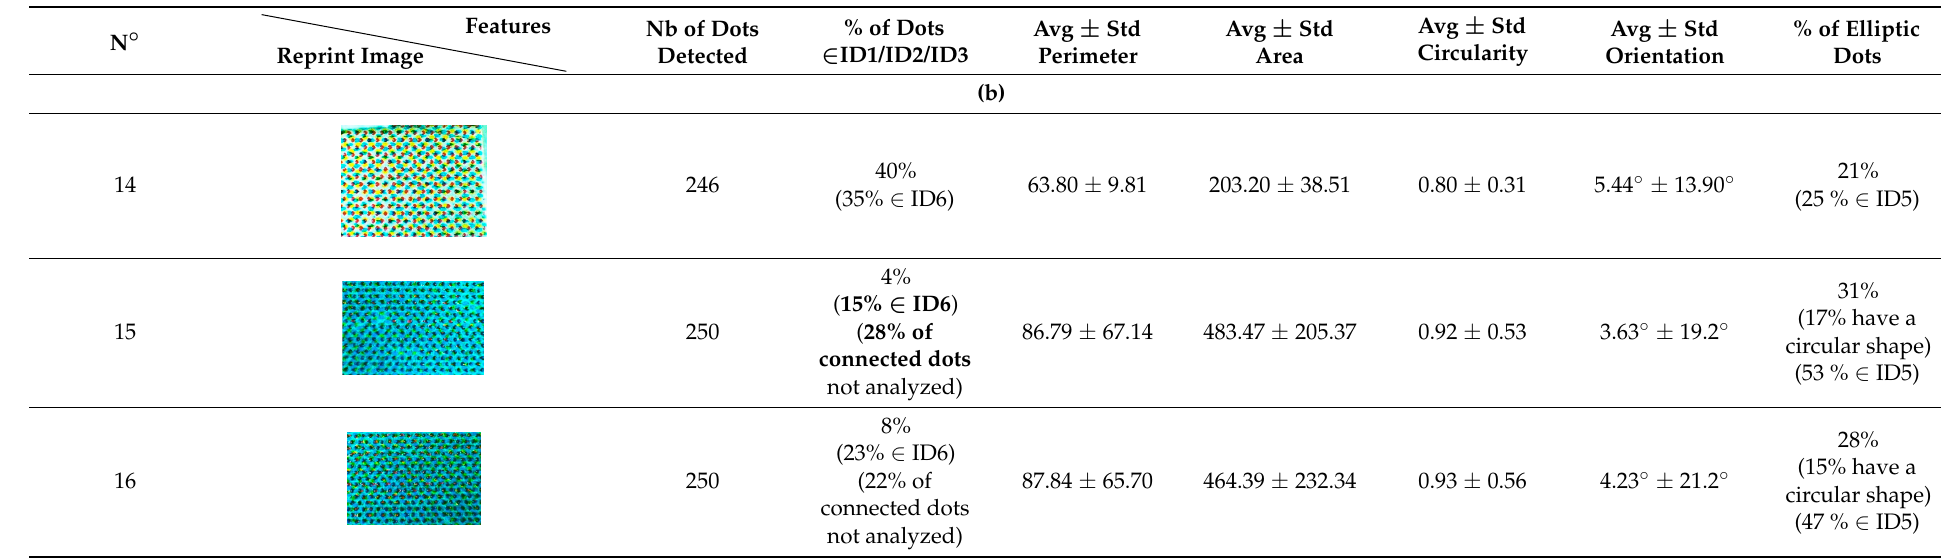
Table 3. Statistical values computed for print yellow dots. The most significant values are in bold.